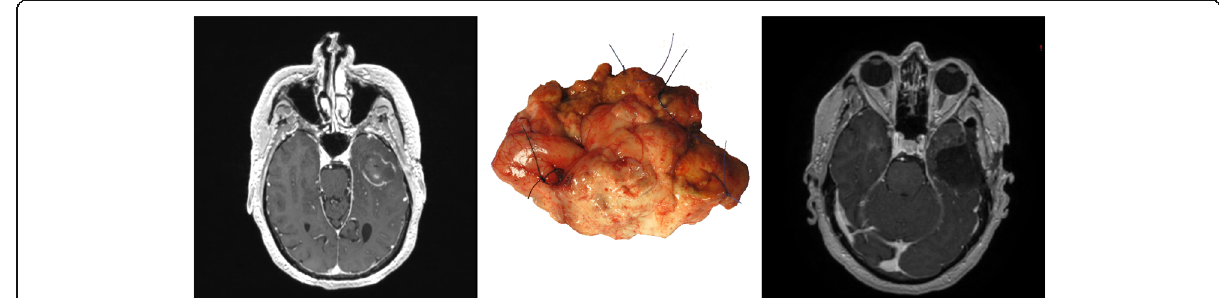
Fig. 2 Magnetic resonance (MR)-imaging and pathologic findings at resection of left temporal laser-induced thermal therapy treated glioblastoma multiforme (GBM). Preoperative (before resection) T1-weighted post-contrast MR-imaging in the axial (Left ) plane demonstrates enhancing necrotic region of treatment/tumor. ( Middle ) En bloc resection of the enhancing GBM/treatment site and surrounding tumor-infiltrated tissue (6.5 cm anteroposterior and 4.4 cm mediolateral dimension) was performed. Postoperative T1-weighted post-contrast MR-imaging in the axial ( Right ) plane demonstrates complete resection of the enhancing necrotic region of treatment/tumor